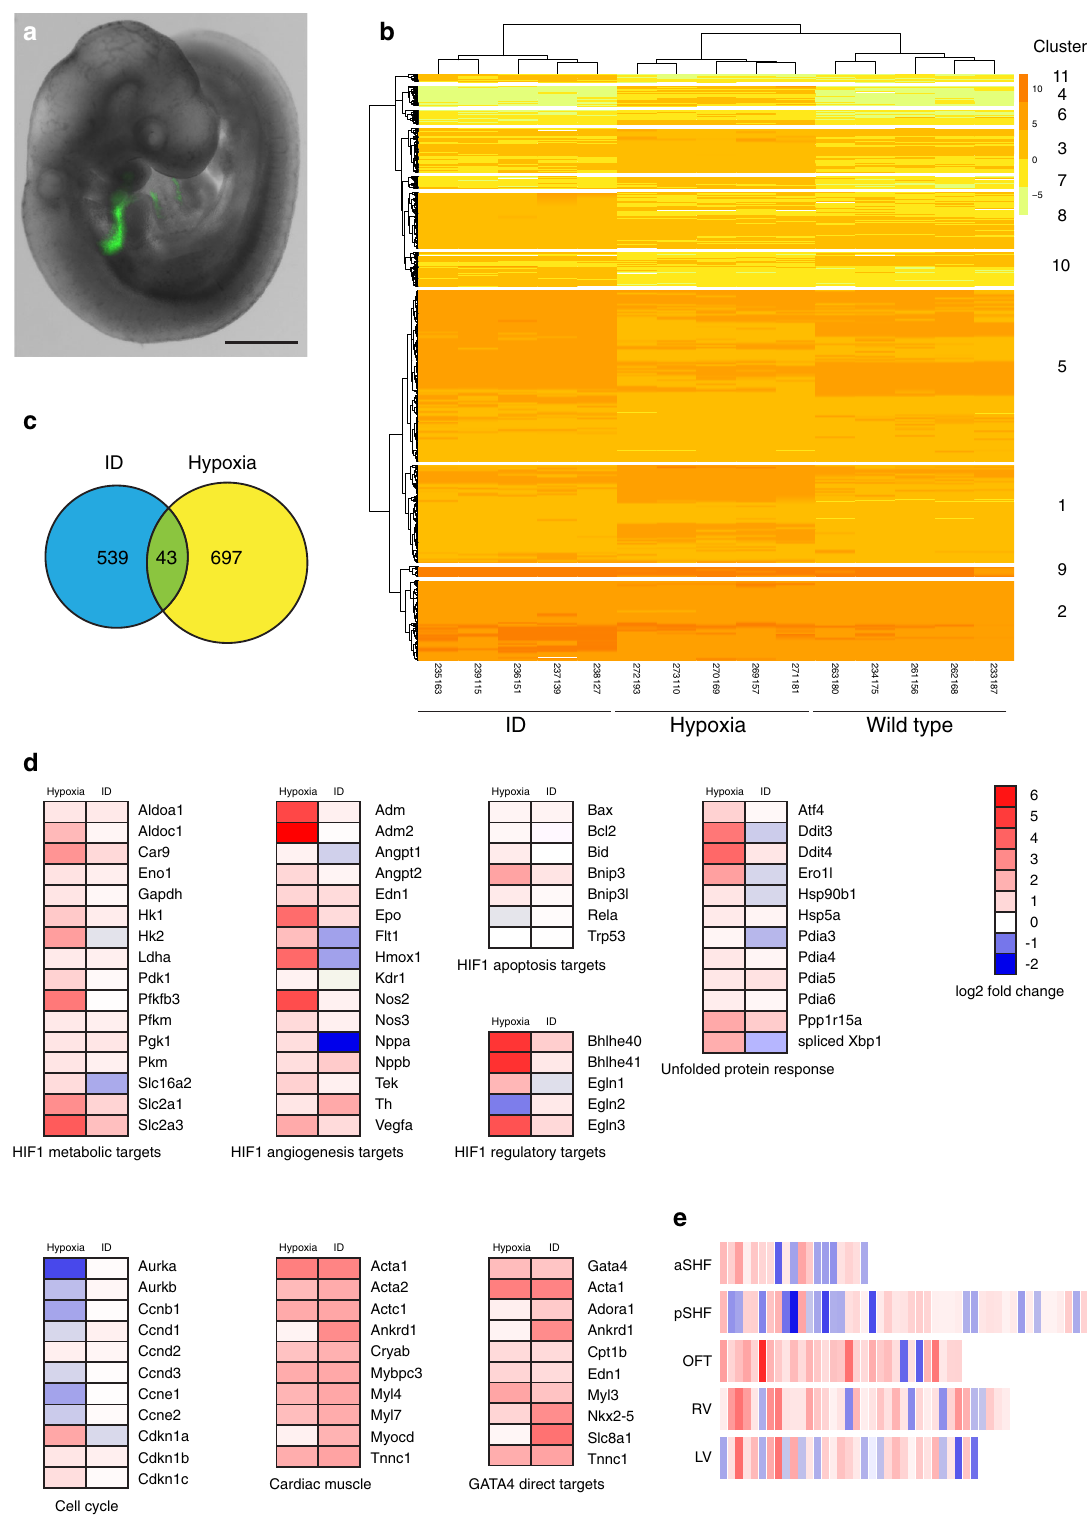
model, including Tbx1 null 29,37 and Hoxb1 null 16 embryos. In these models, premature differentiation of aSHF cells at E9.5 causes similar phenotypes to ID, namely defective OFT elonga- tion, alignment and septation, resulting in a speci fi c set of cardiac defects by E15.5, including membranous VSDs (with or without DORV or OA), transposition of the great arteries (TGA) and persistent truncus arteriosus (PTA), as well as AA anomalies.